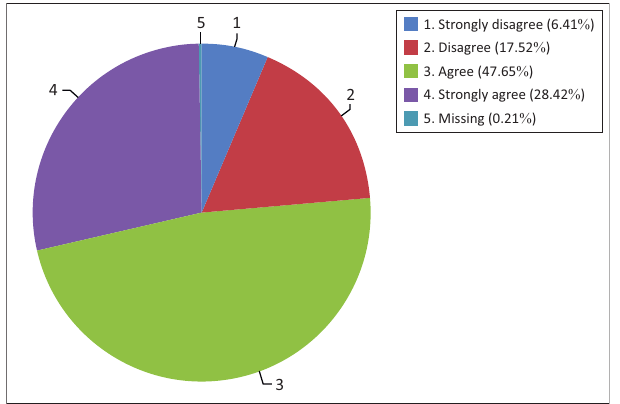
FIGURE 4: Participants who considered reading a hobby before attending the intermediary programme.